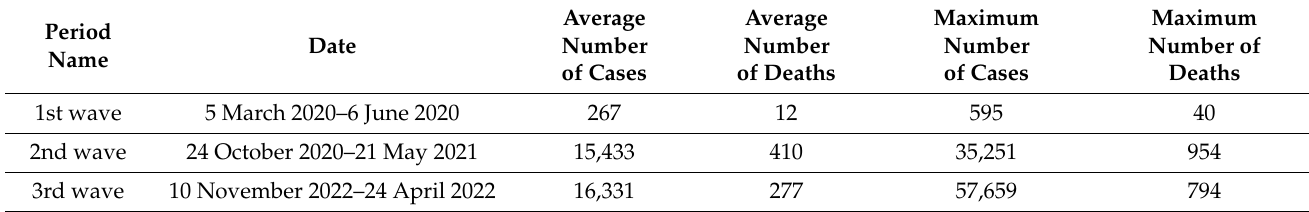
Table 1. Characteristics of individual periods of the COVID-19 pandemic [35].